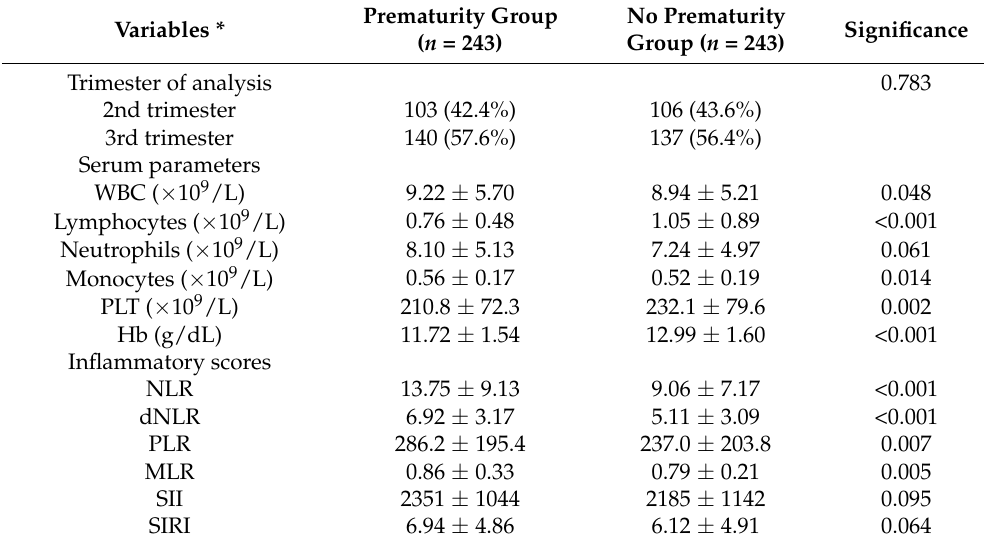
Table 2. Laboratory analysis of pregnant women included in the